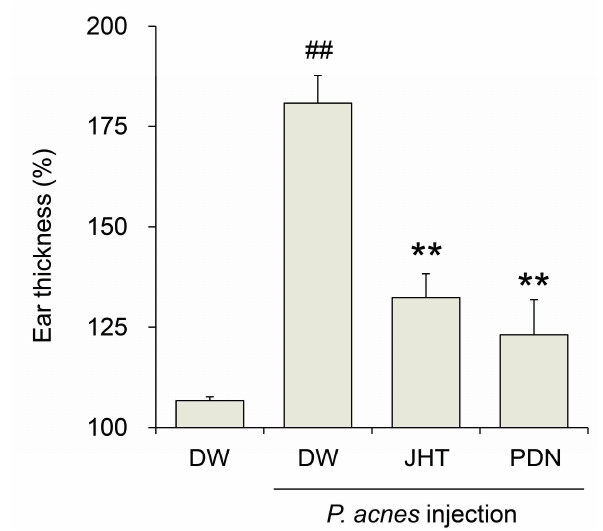
Figure 1. Suppression of Propionibacterium acnes (P. acnes) -induced dermatitis in rats by jumihaidokuto (JHT) administration. Dermatitis was induced in rats by injection of P. acnes (0.14 mg/50 μ L/ear) into the pinna. The ear thickness was measured at 0 and 24 h after the injection. JHT suspended in distilled water (DW) was administered orally at a dose of 0.5 g/10 mL/kg at 1 h before and 6 h after the injection. Prednisolone (PDN, 10 mg/10 mL/kg) was used as a reference drug. Data represent the relative ear thickness, which was standardized against the previous values before the injection. N = 5. ## p < 0.01 vs. saline + DW group (Student’s t -test), ** p < 0.01 significant vs. P. acnes + DW